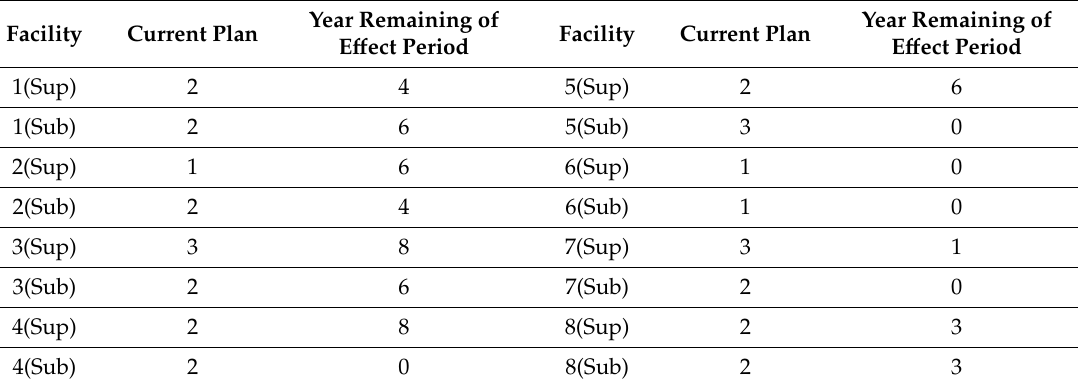
Table 5. Current status of bridges.